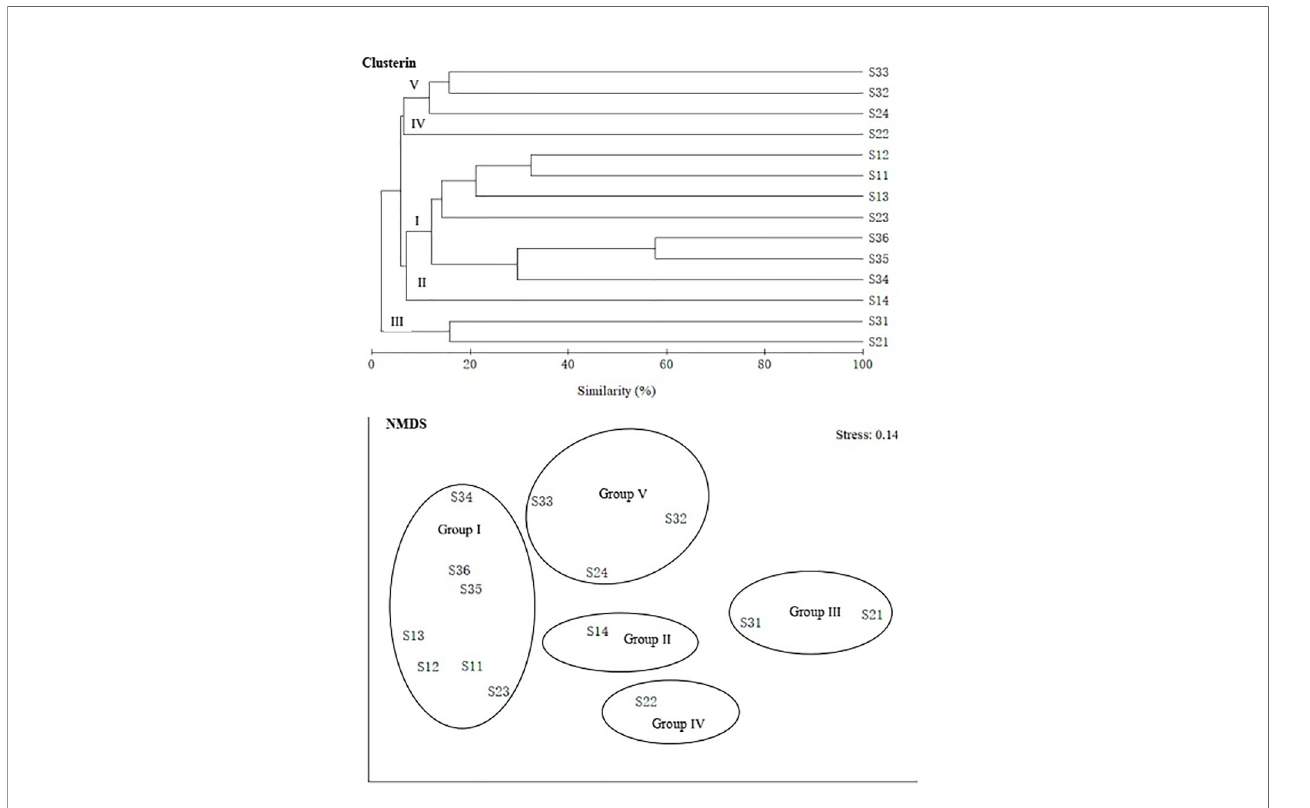
FIGURE 6 | Group average clustering and non-metric multi-dimensional scaling (NMDS) among species of demersal fi sh over the NCSSCS.